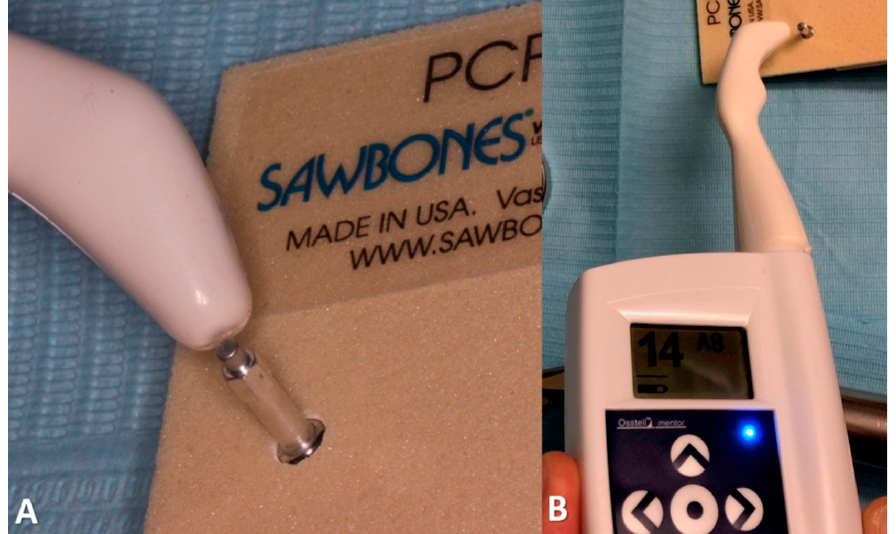
Figure 5. Control Group: RFA measurement of the implant positioned in the polyurethane block. The evaluation was repeated two times for each measurement. ( A ) Dental implant micromovement evaluation through the RFA implant stability. ( B ) Detail of the measurement of the implant stability quotient (ISQ).